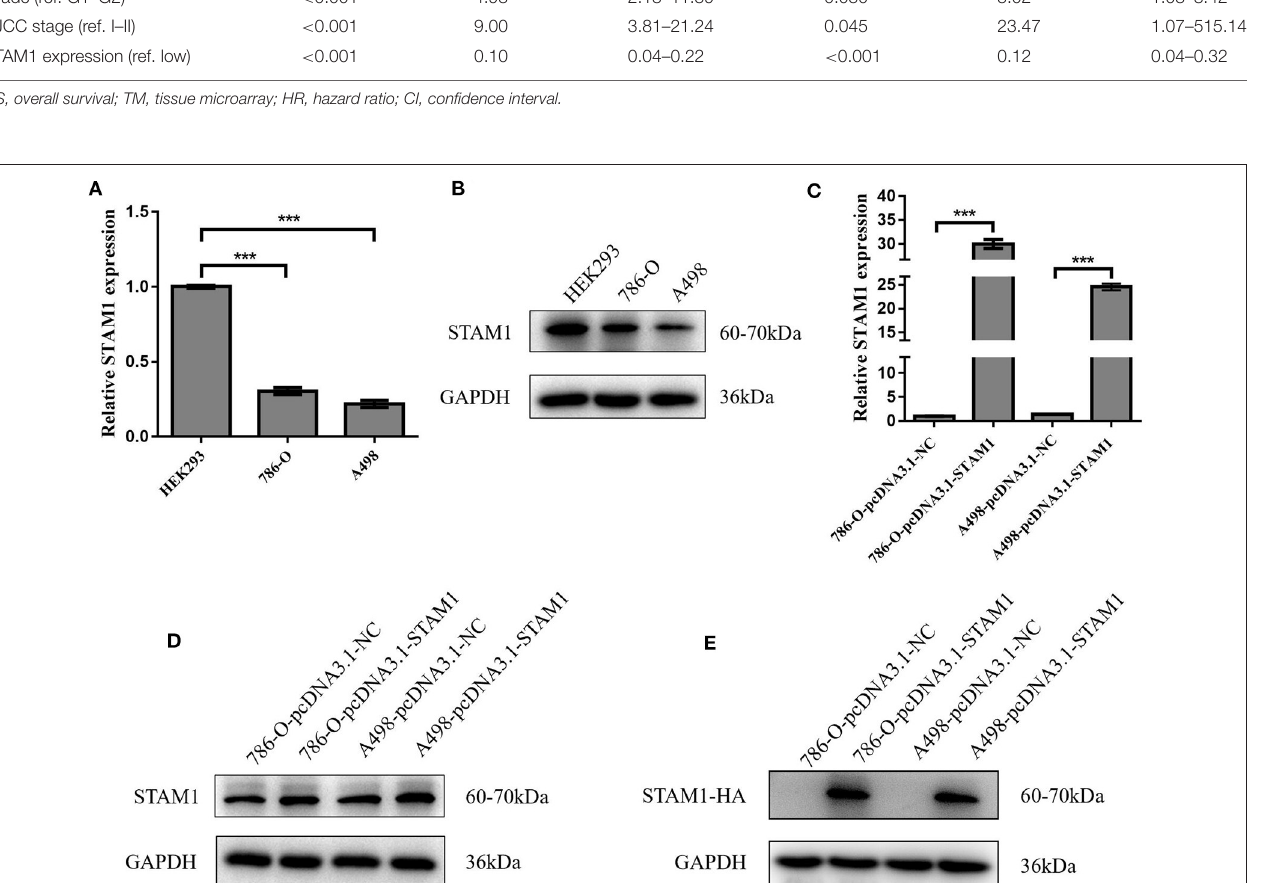
Frontiers in Oncology |